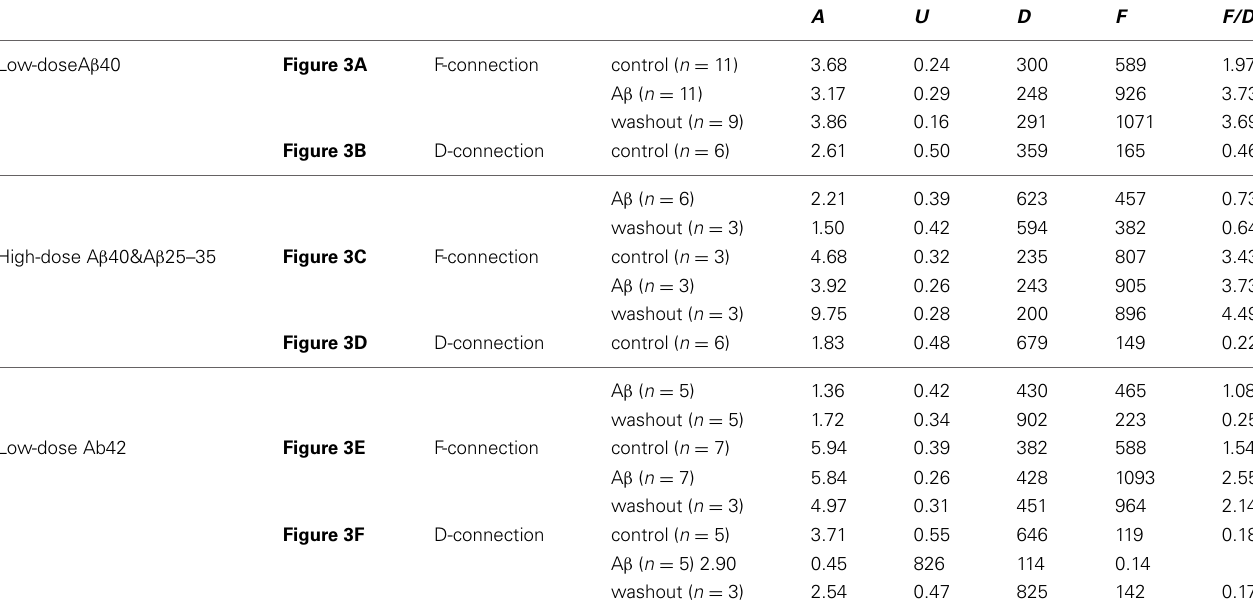
Table A1 | Changes of synaptic dynamic properties in the modeling